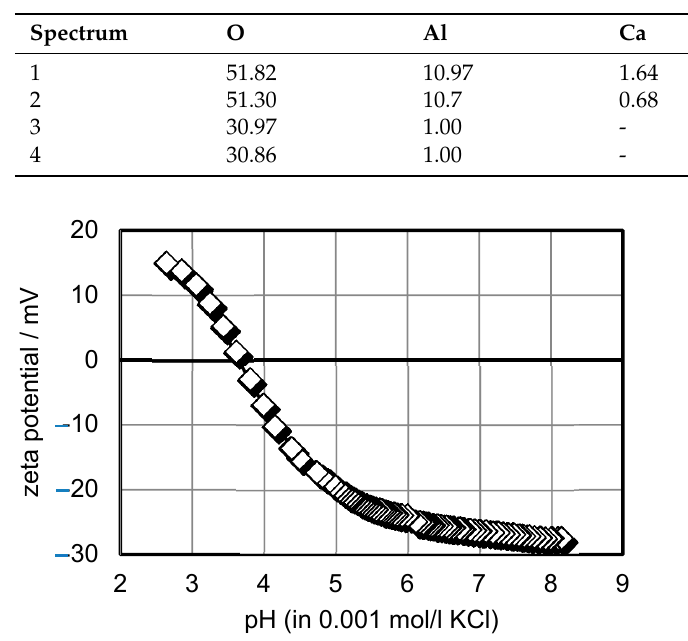
Figure 6. The membrane zeta potential measurement.